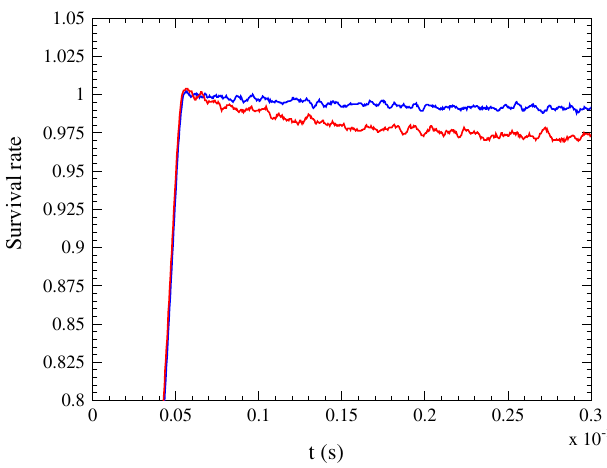
FIG. 28. (Color) Beam survival rates in the first 3 ms measured for the same intensity beam as that in Fig. 26 with no beam painting scheme in the 181 MeV beam storage mode, where the extraction DC magnets were excited at 181 MeV (blue curve) or 3 GeV (red